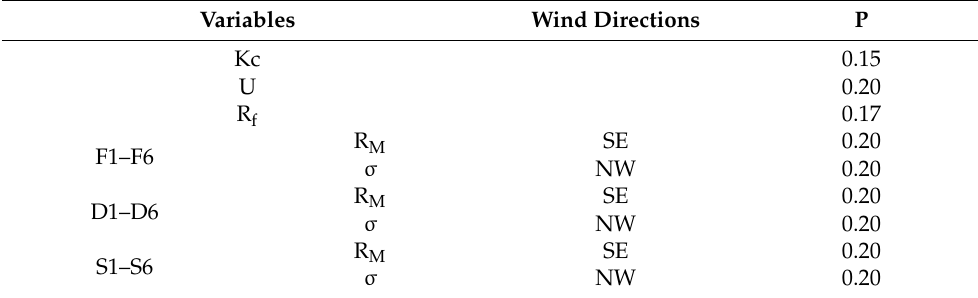
Table 11. The significance